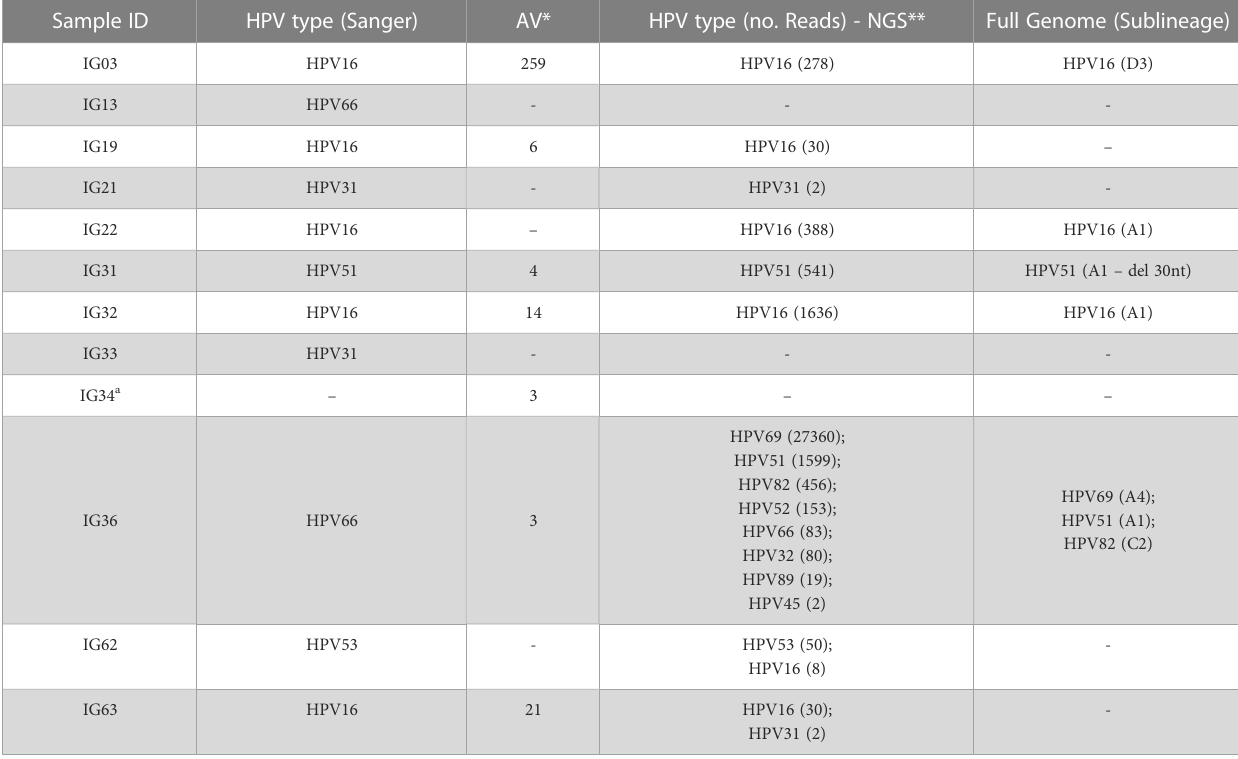
TABLE 3 Patient viral pro fi les based on Sanger sequencing and next-generation sequencing. Sample